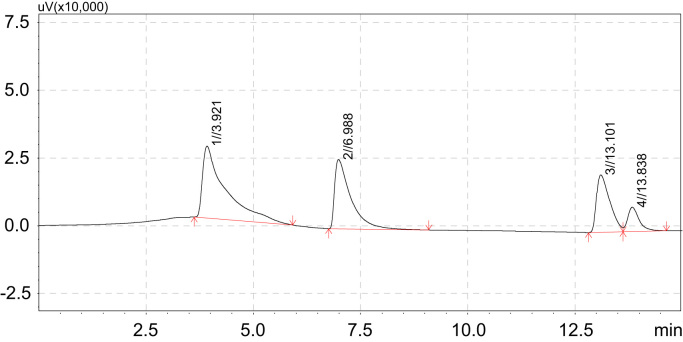
Sample standard.